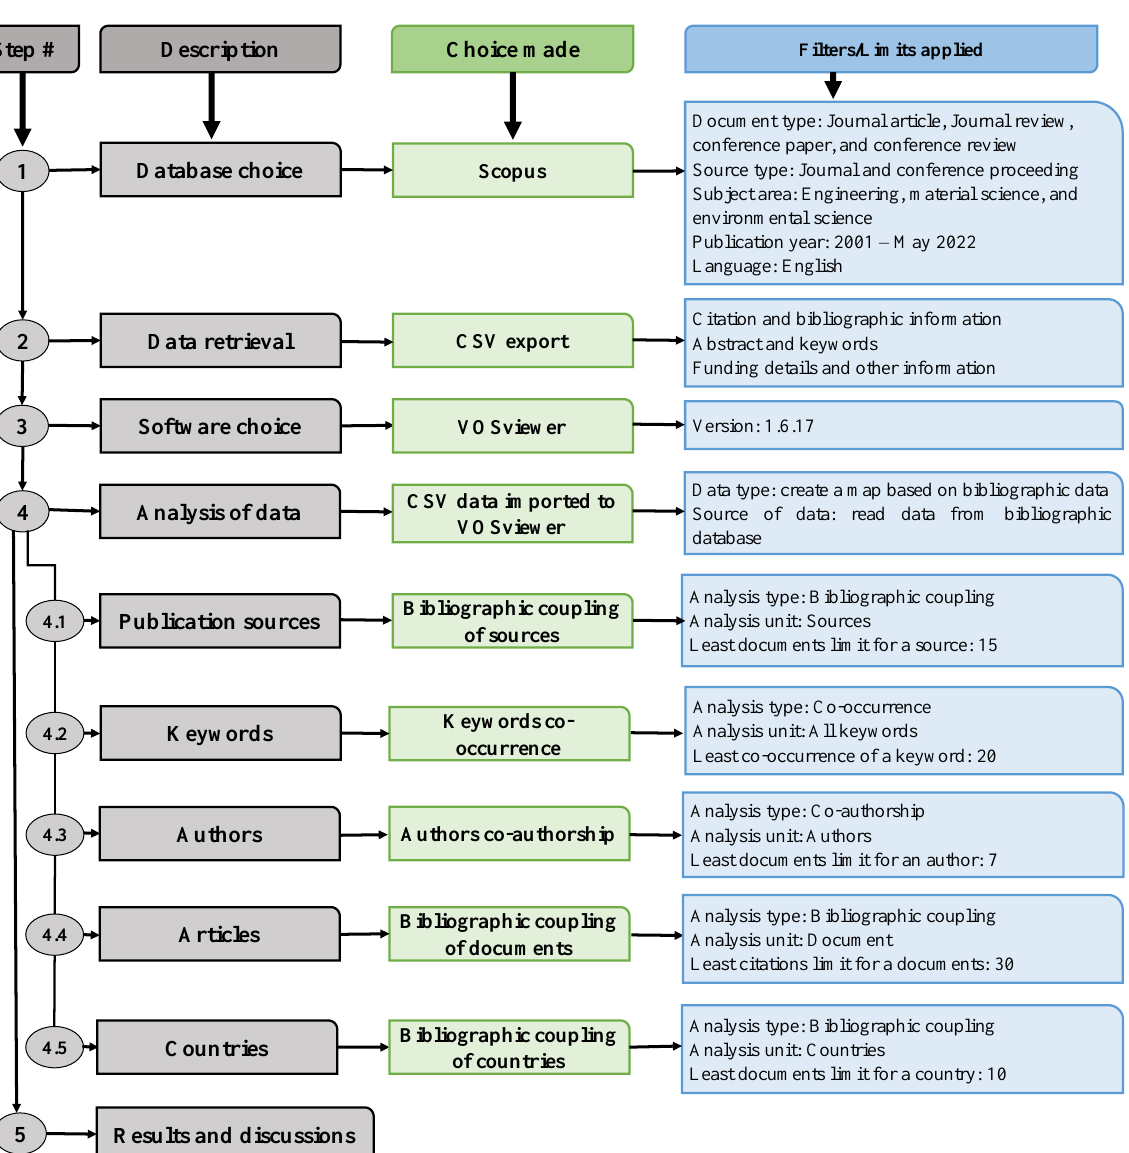
Figure 2. Flow chart of the study’s strategy , indicating various choices selected and limits applied Figure 2. Flowchart of the study’s strategy, indicating various choices selected and limits applied during each step. during each